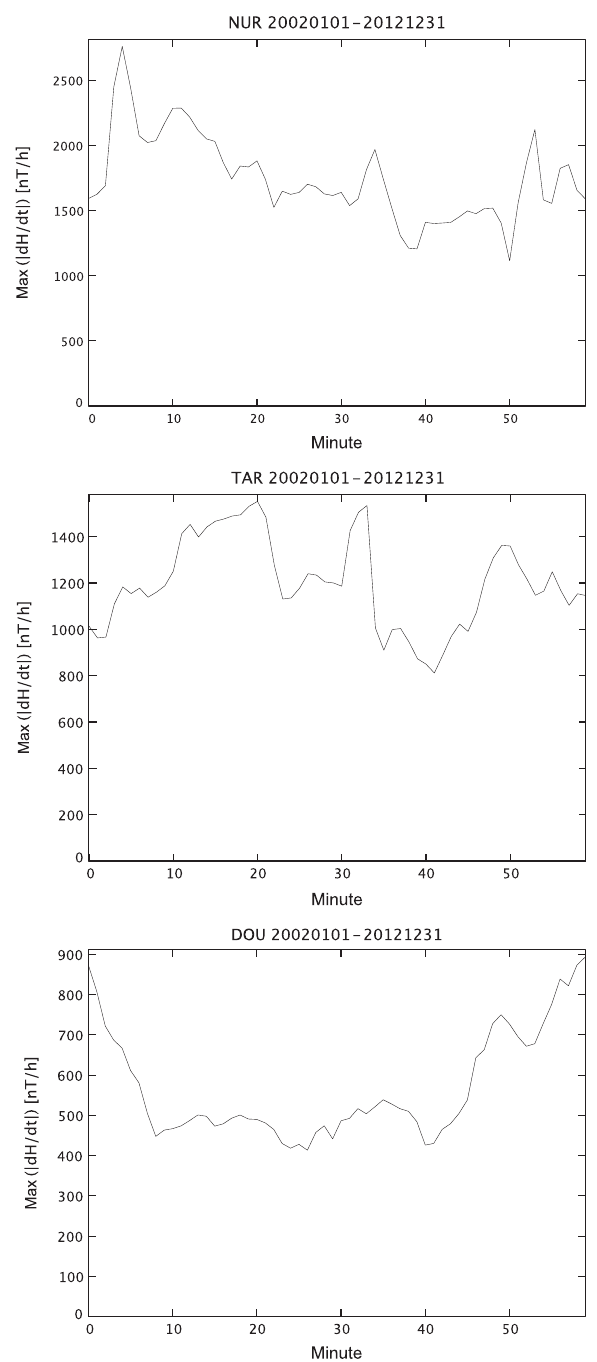
Fig. 6. From top to bottom: Maximum hourly |d H /d t | at NUR, TAR and DOU in 2002–2012 for 1-h times series starting at minutes 00, 01, ... , 59 (horizontal axis). Compare also to Figure